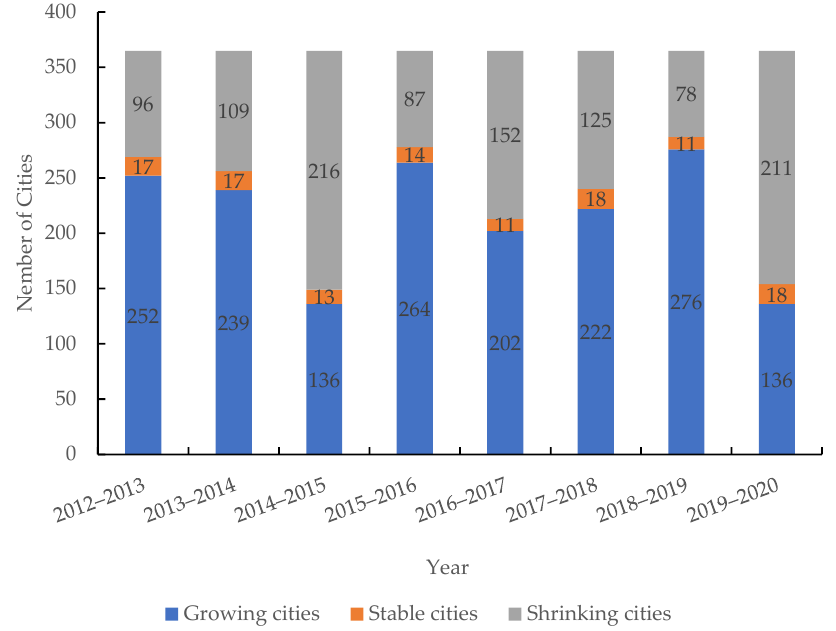
Figure 5. Temporal changes in the number of shrinking cities in China, 2012 – 2020.